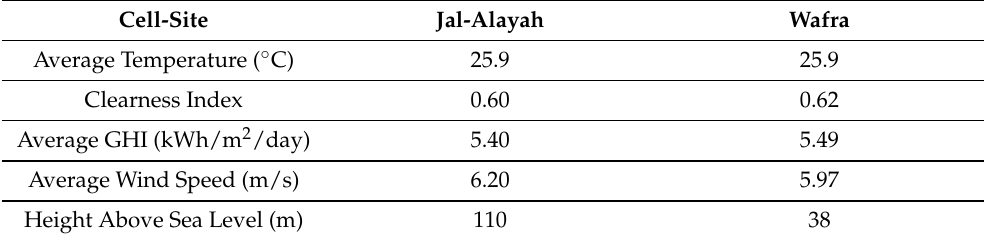
Table 1. Average annual characteristics of Jal-Alayah and Wafra cell-sites [40].